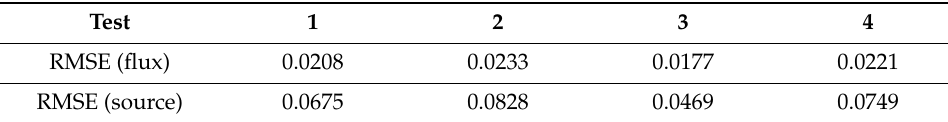
Table 2. RMSE calculated for the four tests.